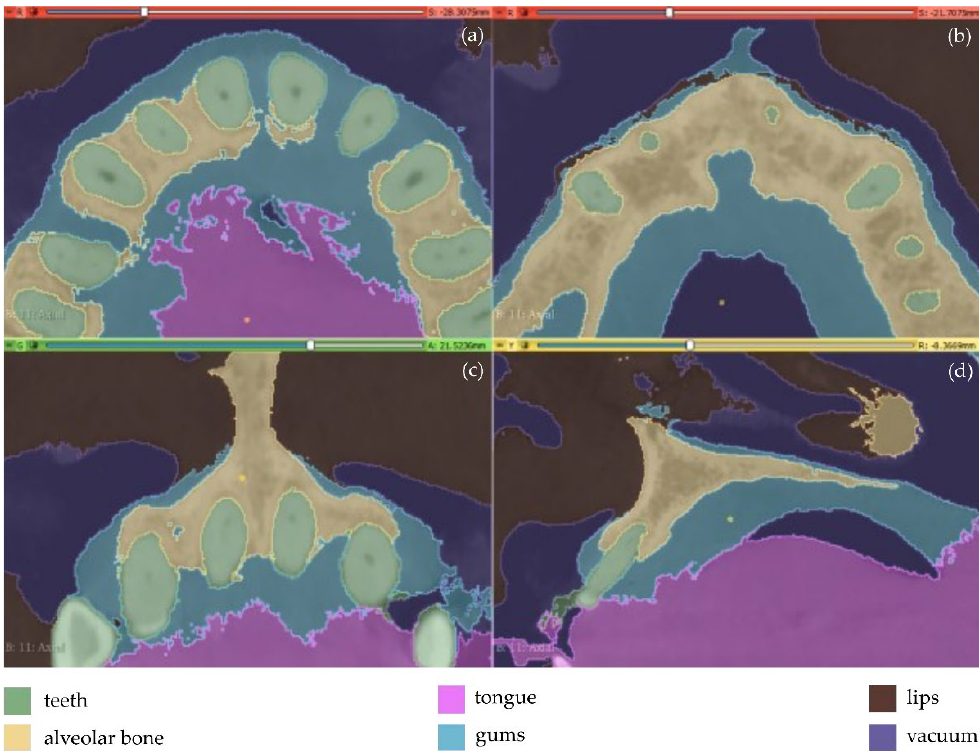
Figure 5. Segmentation results for Experiment 2 after the application of the “Grow from seeds” method, superimposed over CBCT slices in the axial plane ( a , b ), the coronal plane ( c ), and the sagittal plane ( d ).